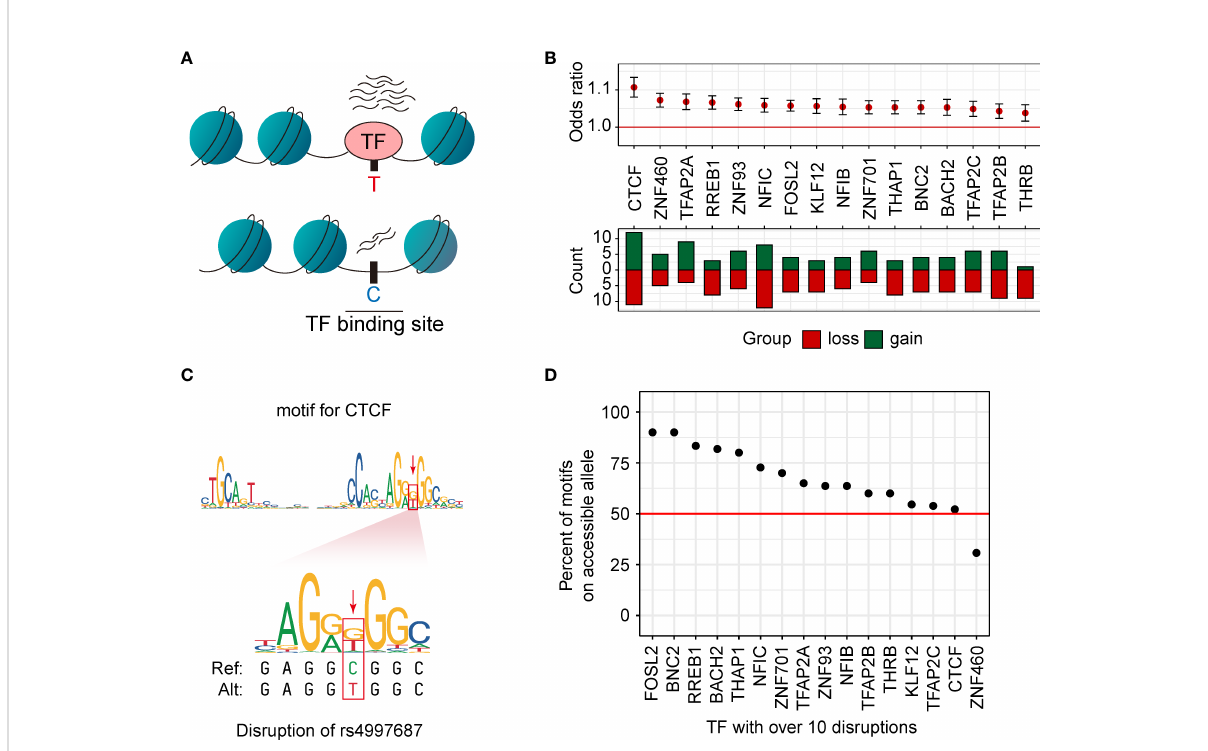
FIGURE 4 caQTLs disrupted the binding sites of TFs. (A) Motif disruption analysis was performed using the caQTL SNPs in their related caQTL peaks. (B) Disruption of motifs is signi fi cantly associated with the caQTL status. Loss, the reference alleles match the motif better. Gain, the alternative alleles match the motif better. (C) An example of the disruption of rs4997687 in the motif of CTCF . (D) The proportion of the disrupted motifs for which the allele with higher chromatin accessibility matched the motif better. Only the 16 TFs with more than ten disruptions are shown. The red line represents the average percent across the 16